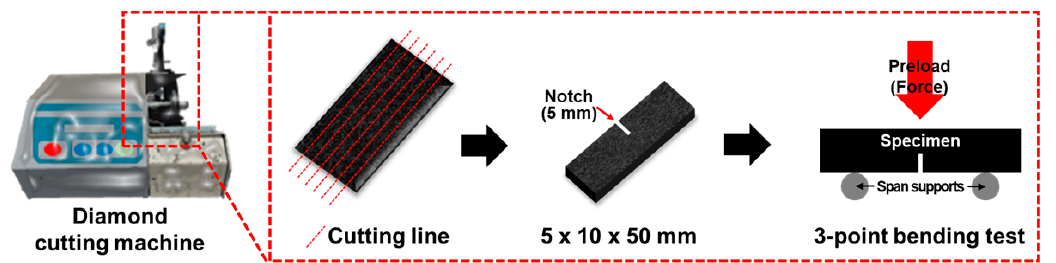
Figure 9. Testing details for fracture toughness ( K IC ) specimens.